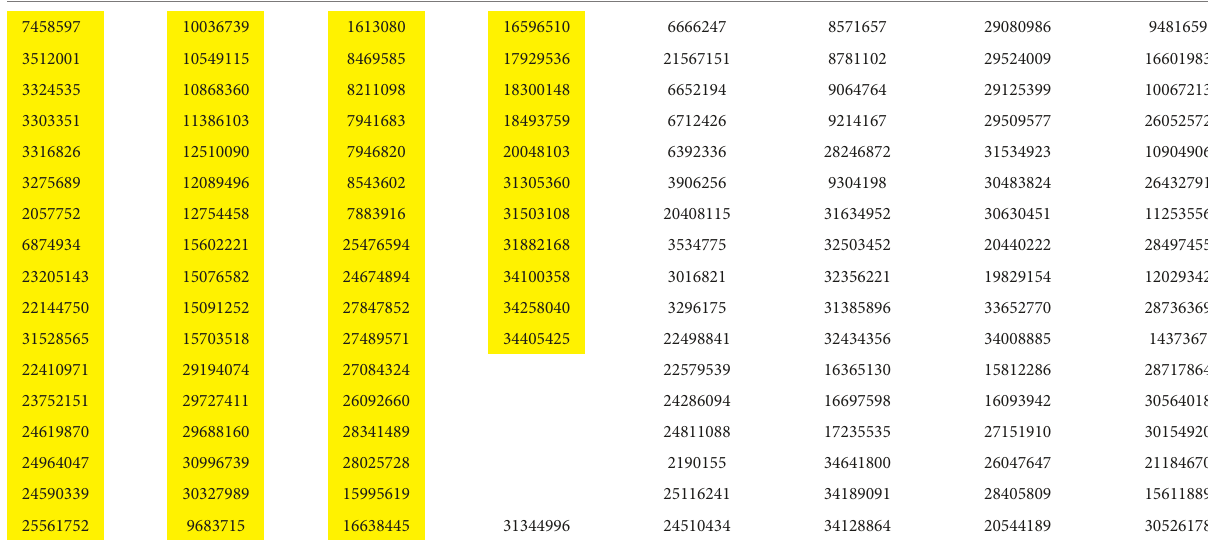
TABLE 1 Pubmed-IDs (PMID) of all 131 analyzed studies.